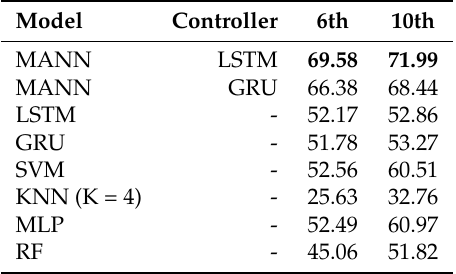
Table 4. Accuracies of the first ten instances without training in Domain 2 of the FFRI 2017 dataset. The best result is archived by using feature vectors generated from word2vec in the skip-gram model with the parameters: n-gram of 1, vector-size of 50, window-size of 5, min-count of